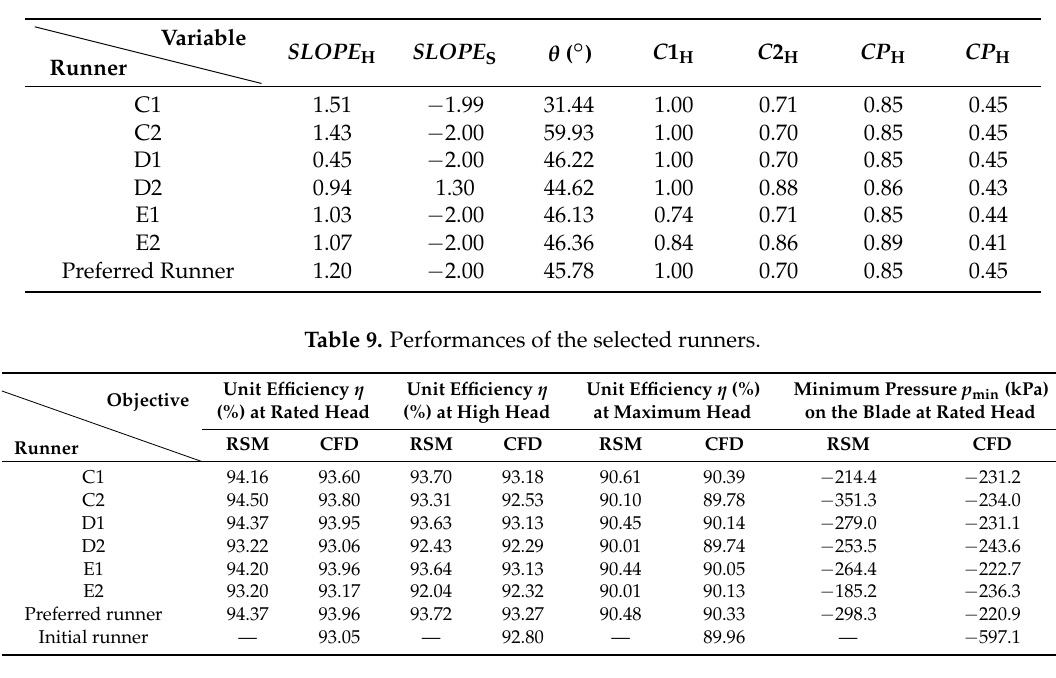
Table 8. Optimized input parameters by the second step optimization.